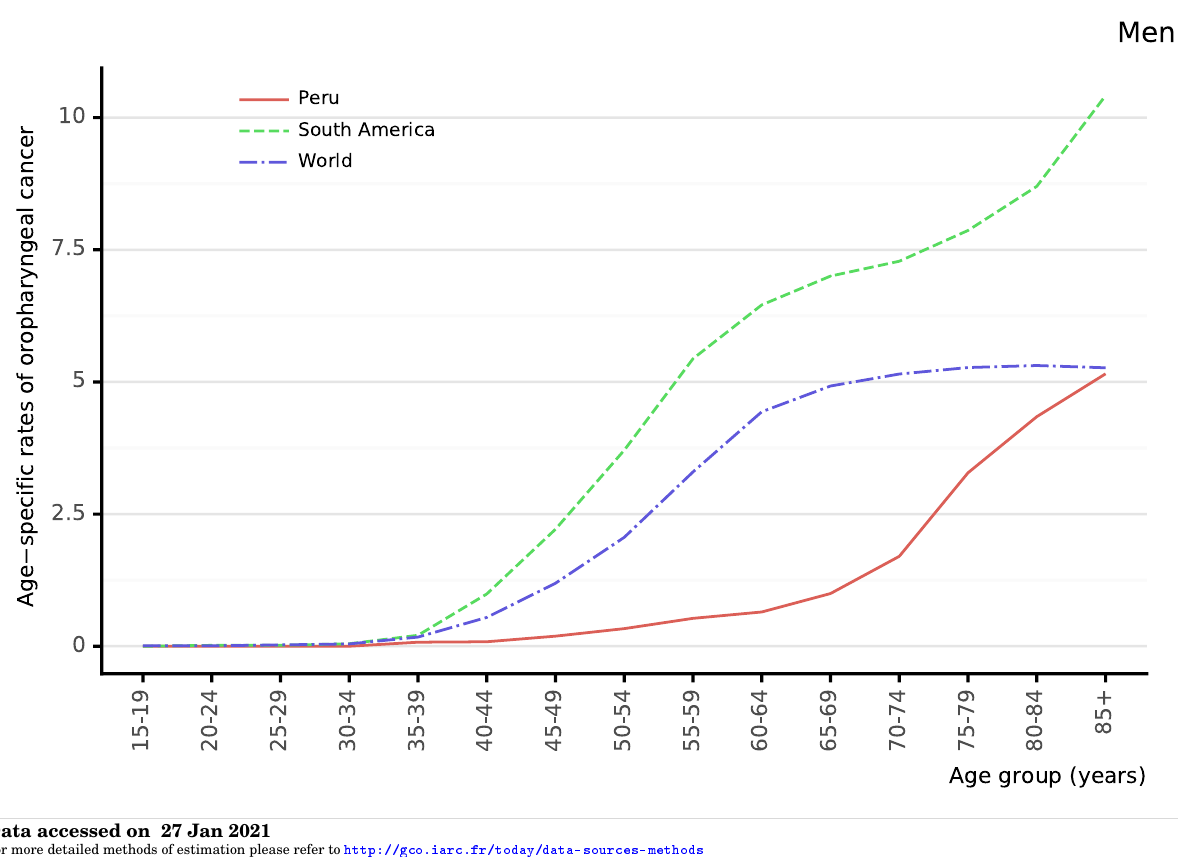
Figure 125: Comparison of age-specific oropharyngeal cancer mortality rates among men by age in Peru, within the region, and the rest of